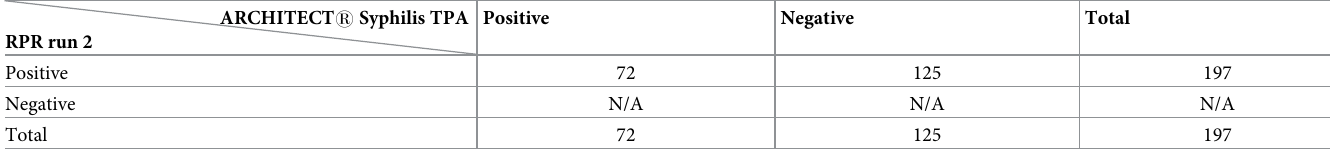
Table 6. Comparison between RPR run 2 and